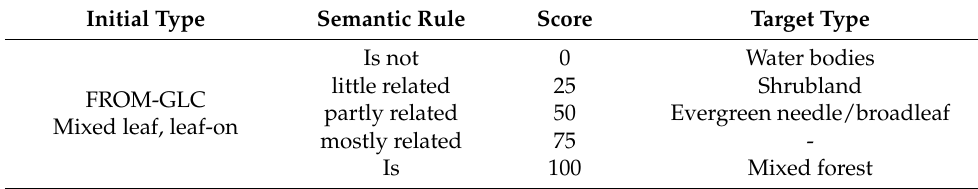
Table 2. Example of affinity